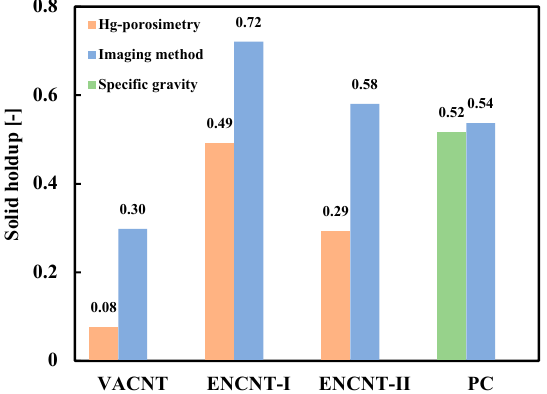
9 of 13 Figure 9. ( a ) Surface photograph of ENCNT-I in loosely packed bed; ( b ) processed image of Figure ( a ); ( c ) two- dimensionally simulated photographs for given solid holdups. 3.2. Solid Holdup in CNT Fluidized Bed Figure 10 compares the solid holdups at the minimum fluidization, which were based on the imaging and the Hg-porosimetry methods. The solid holdups were calculated by the Equation (1) with the measured pressure drop across the fluidized bed. The solid holdups obtained by the imaging method were higher than those by the Hg-porosimetry, similar to the results in Figure 8. In particular, the solid holdup of the VACNT from the Hg-porosimetry was a very low value of 0.08, which is generally found in the dilute phase of the fast fluidized bed [11] and is hard to occur under the minimum fluidization condition. Interestingly, the solid holdups at the minimum fluidization exhibited relatively low values compared to the loosely packed bed condition. The CNT fines and